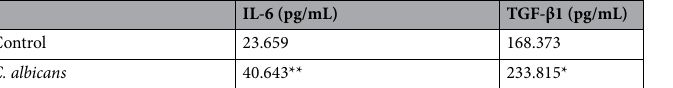
Table 5. Mean concentration of IL-6 and TGF-β1 in the endometrium of rats in the C. albicans and control groups, as determined by ELISA. ELISA enzyme-linked immunosorbent assay, IL-6 interleukin-6, TGF-β1 transforming growth factor-β1. * P < 0.05, ** P < 0.01 compared with